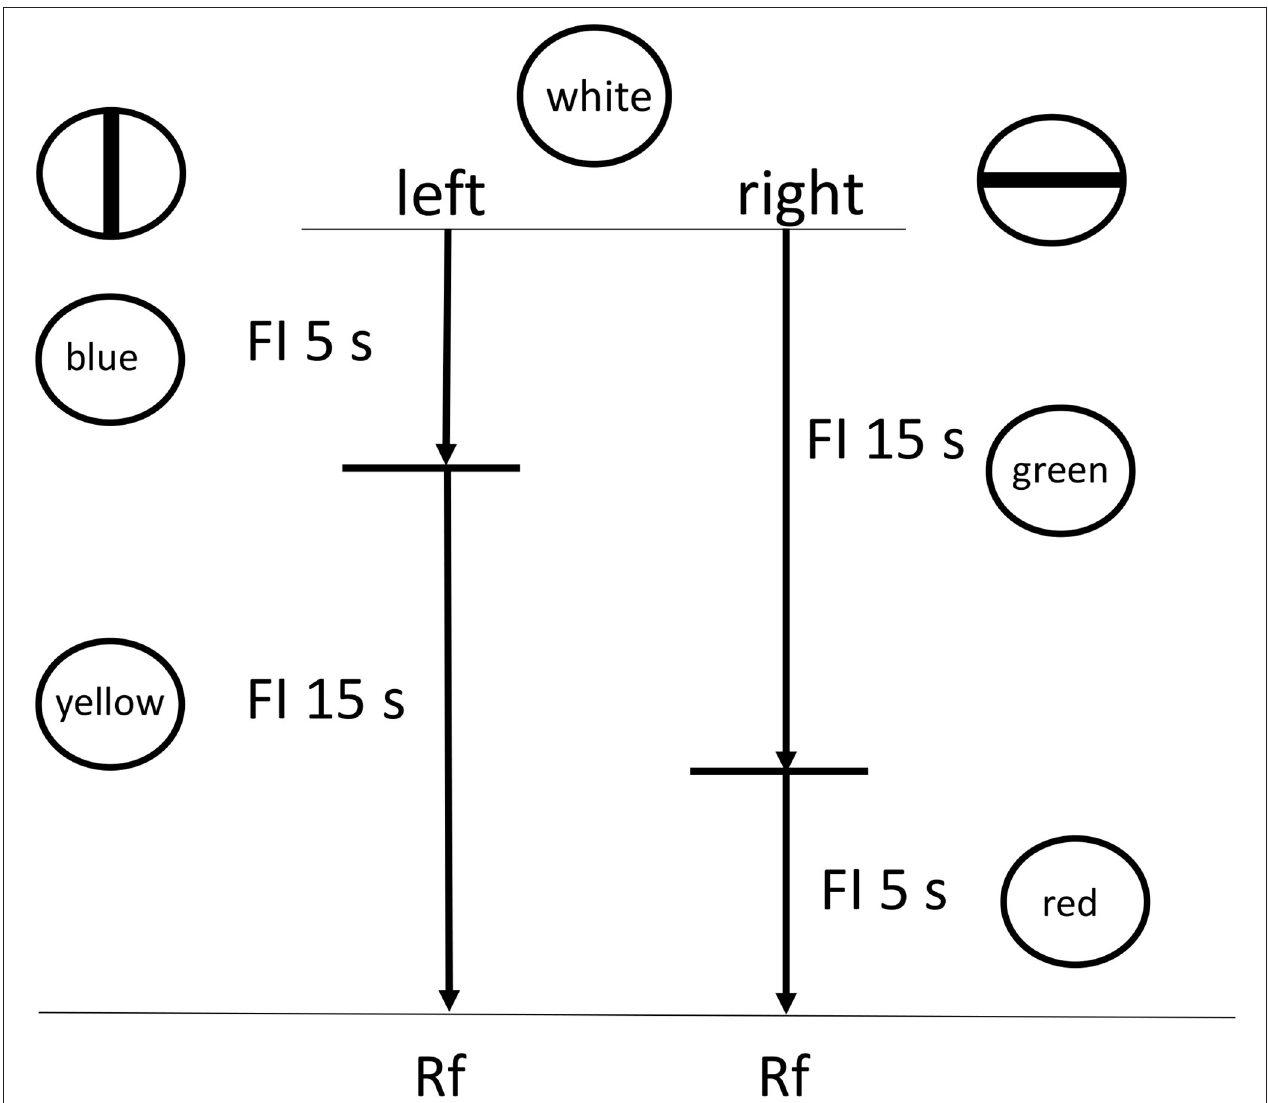
FIGURE 6 | Design of the Zentall et al. (2018) experiment. Pigeons were given a choice between two reinforced chains, short (FI 5s) followed by long (FI 15s) or long (FI 15s) followed by short (FI 5s).